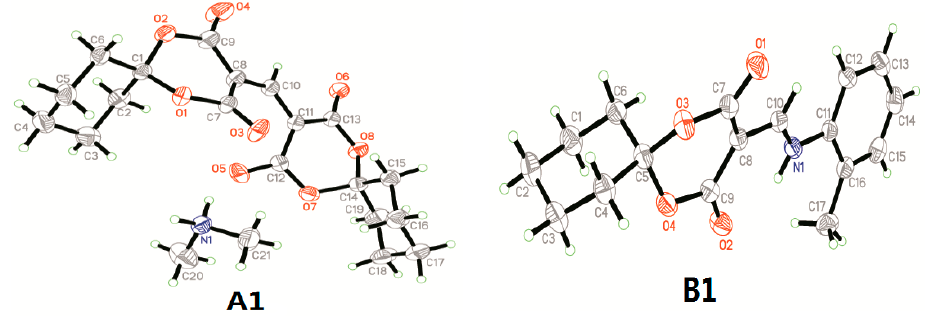
Figure 1. ORTEP drawing of A1 and B1 with thermal ellipsoids at 30% probability level.